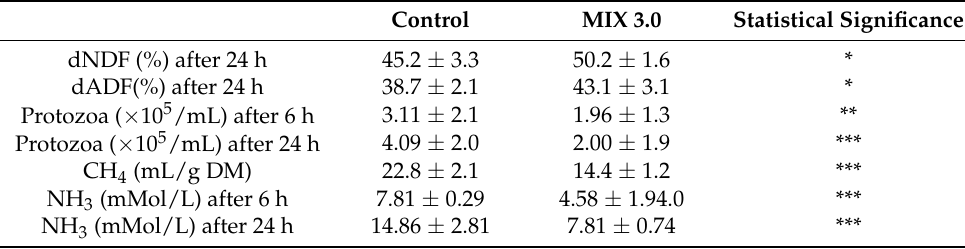
Table 1. Counting of protozoa, methane production (CH 4 ), fibre digestibility and ammonia (NH 3 ) concentration during in vitro